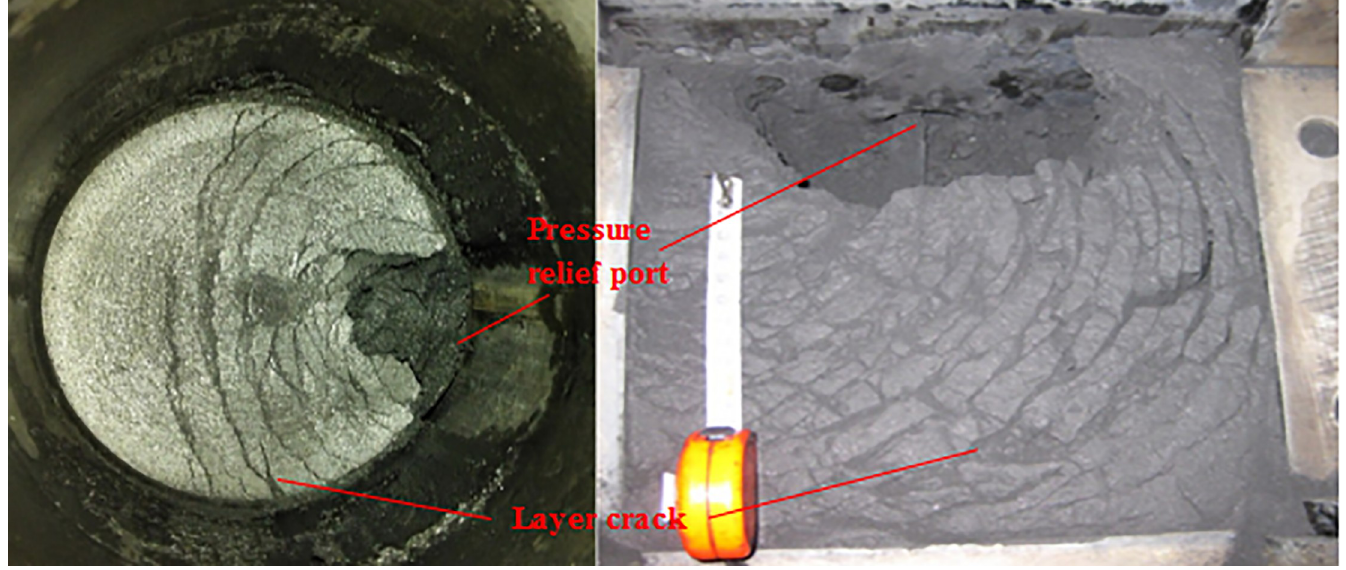
Fig 1. Spallation damage of gas-bearing coal after unloading pressure.